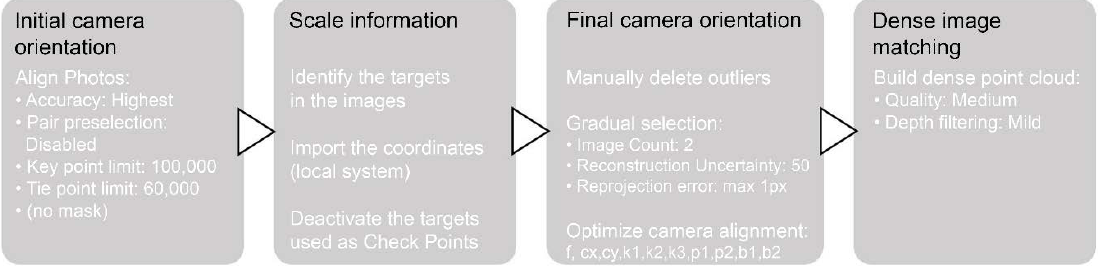
Figure 2. Workflow and parameters used for point cloud generation with Agisoft PhotoScan.